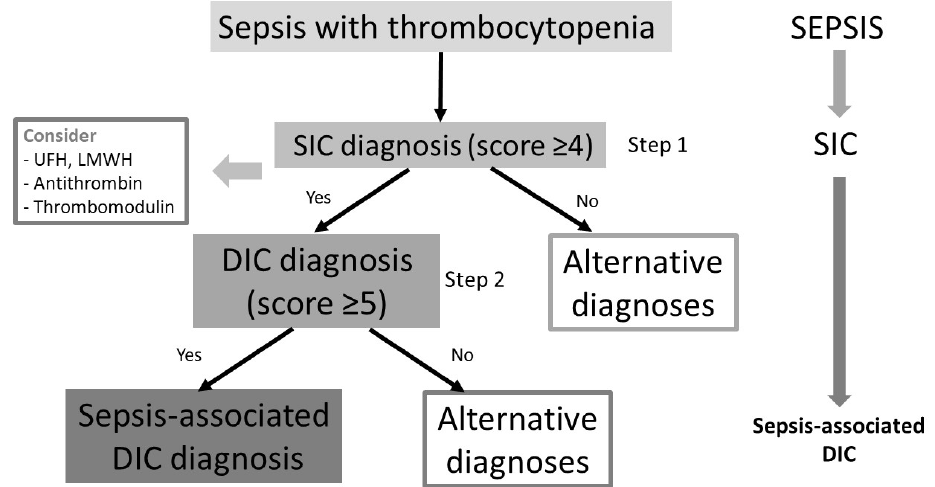
Figure 1. Two-step diagnostic approach to septic coagulopathy: DIC—disseminated intravascular coagulation; SIC—sepsis-induced coagulopathy; LMWH—low-molecular-weight heparin; UFH— unfractionated heparin. Based on [10].